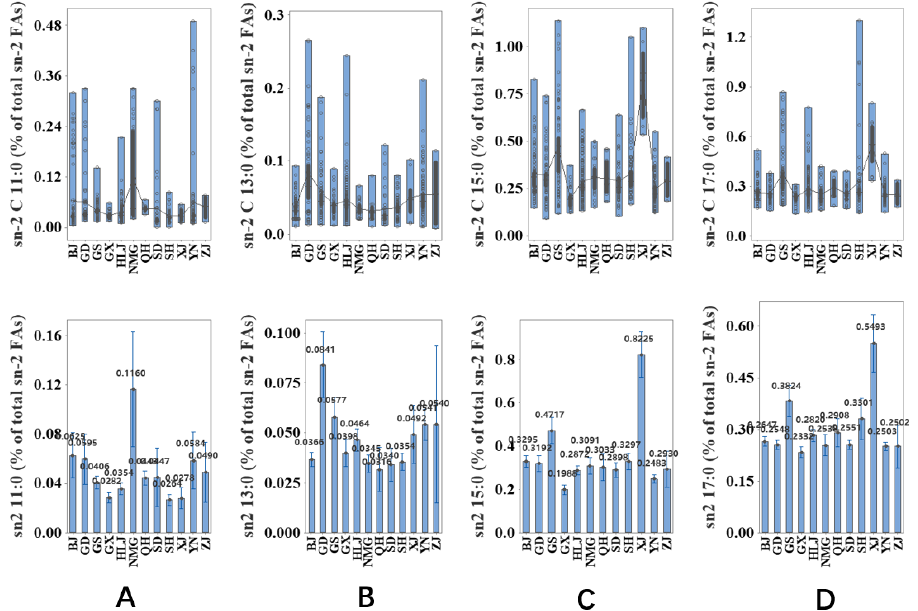
Figure 4. Association between location and the odd-chain fatty acids at sn-2 position (( A ): sn-2 C11:0, ( B ): sn-2 C13:0, ( C ): sn-2 C15:0, ( D ): sn-2 C17:0) in human milk. Undecylic acid = C11:0;